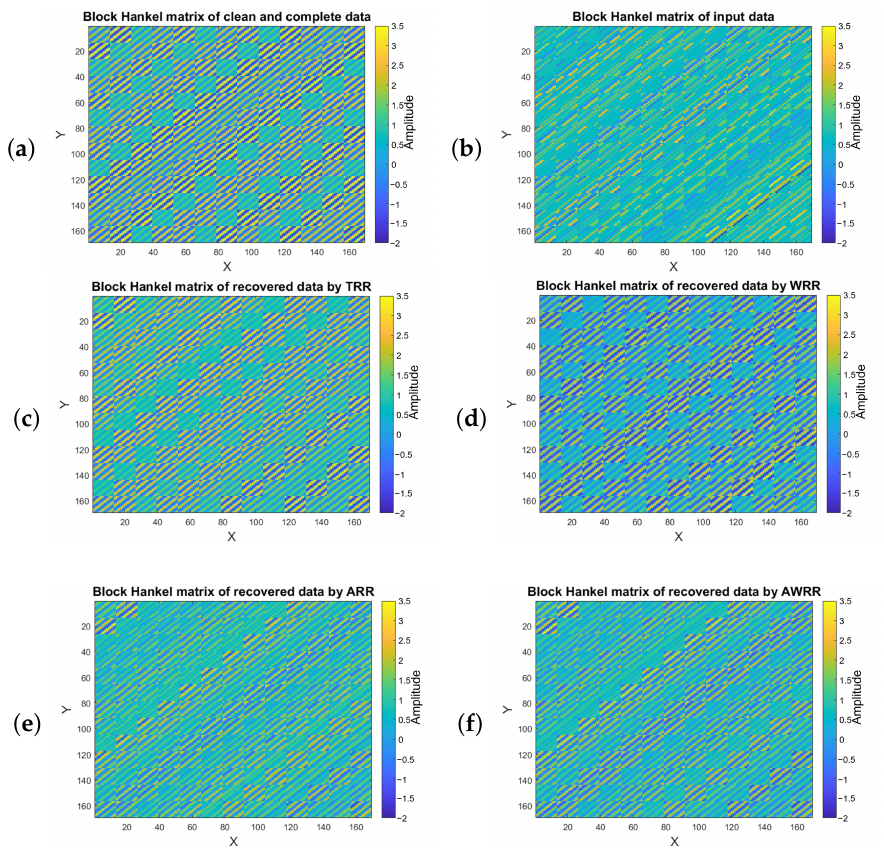
Figure 9. Block Hankel matrices for frequency of 50 Hz for ( a ) clean and complete data and ( b ) data with SNR = 2 and 50% missing traces; ( c ) block Hankel matrix recovered by TRR rank = 4 after ten iterations; ( d ) data recovered by WRR after ten iterations. ( e ) Data recovered by applying the ARR method for ten iterations, and ( f ) data recovered after applying AWRR for ten iterations.